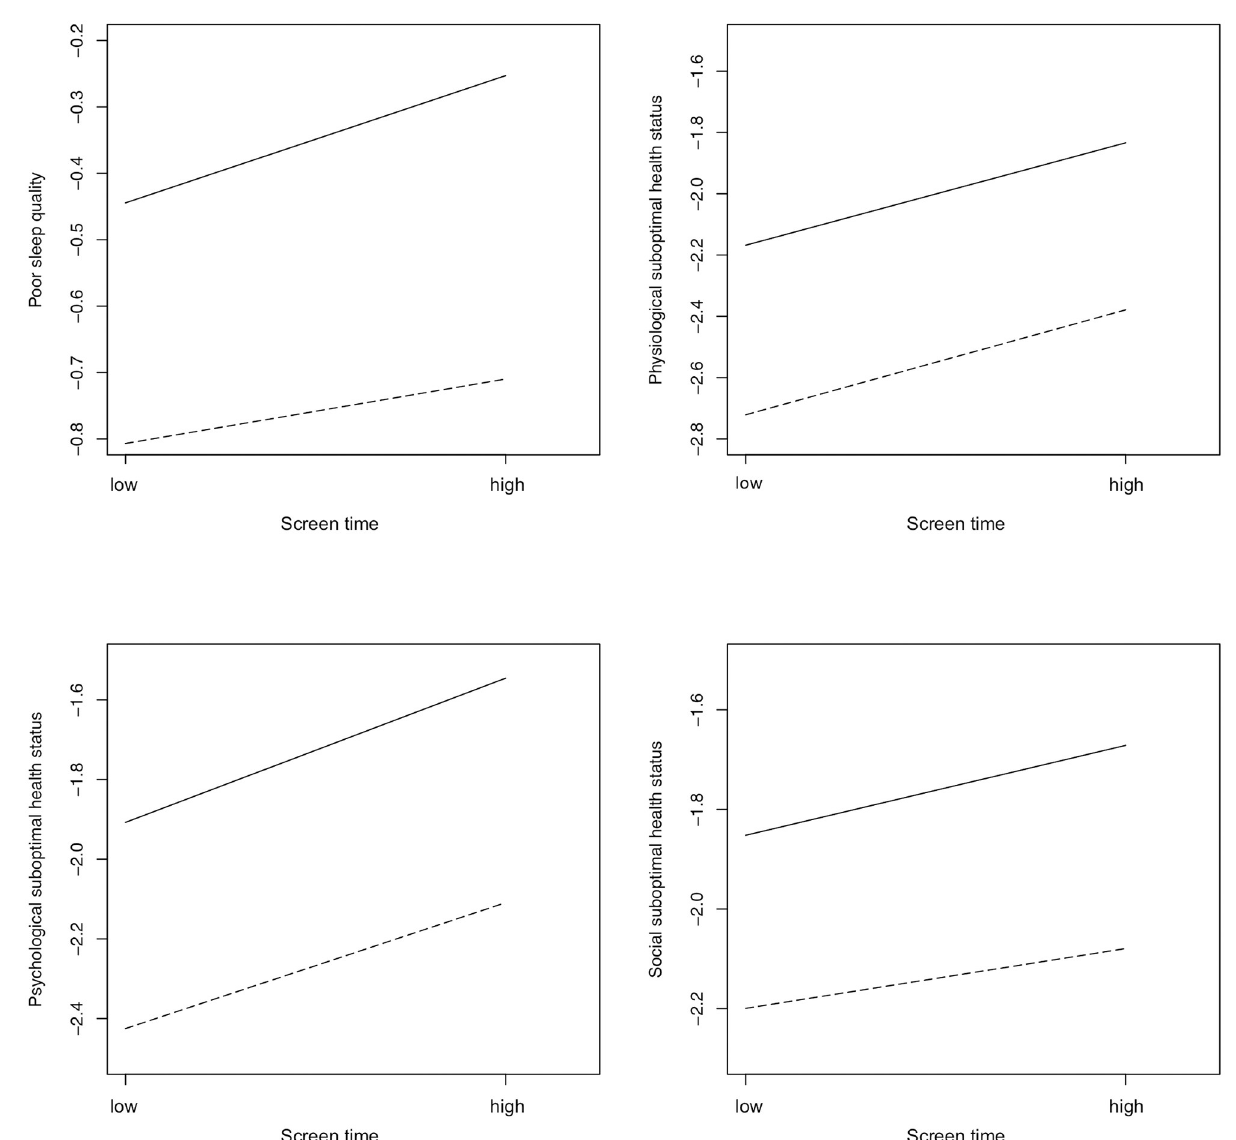
Fig 1. Interactive associations of ST and PA with sleep quality, and physiological, psychological, and social suboptimal health status. Note: Solid line: low PA; dashed line: high PA. Y axis is the logarithm of aOR.